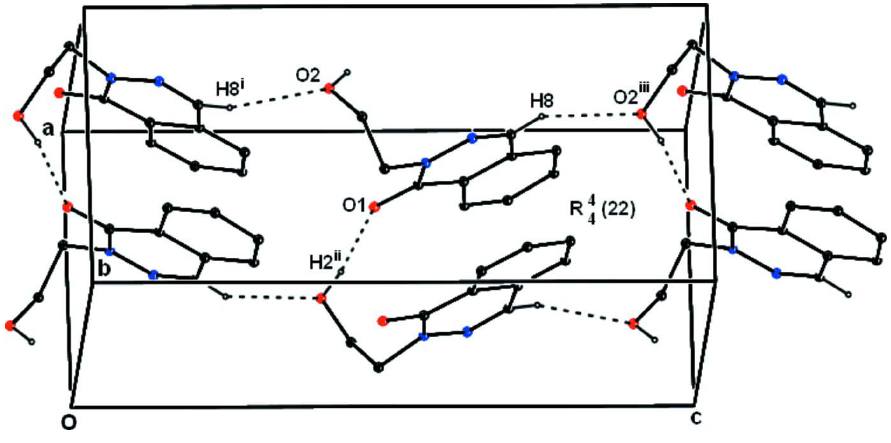
Figure 2 A partial packing diagram of (I), showing the formation of R 44 (22) ring motifs. Hydrogen bonds are shown as dashed lines [symmetry codes: (i) 3/2 - x, y, z - 1/2; (ii) x - 1/2, 1 - y, z; (iii) 3/2 - x, y, 1/2 + z]. H atoms not involved in hydrogen bondings have been omitted for